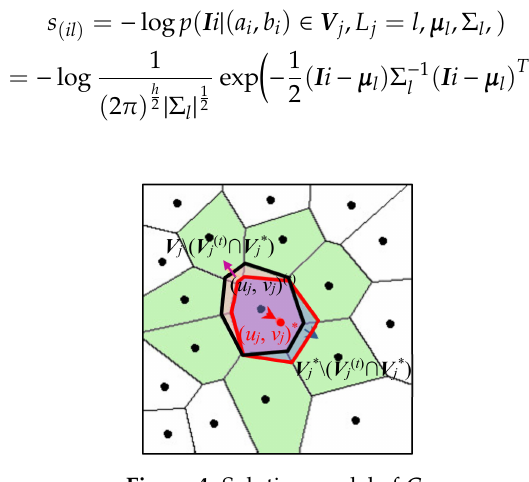
Figure 4. Solution model of G .